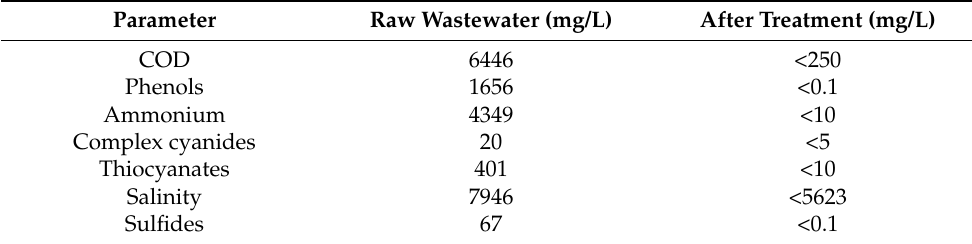
Table 1. Selected values for raw wastewater and after treatment with a final stage involving activated sludge [12]. Parameter Raw Wastewater (mg/L) After Treatment (mg/L) COD 6446 <250 Phenols 1656 <0.1 Ammonium 4349 <10 Complex cyanides 20 <5 Thiocyanates 401 <10 Salinity 7946 <5623 Sulfides 67